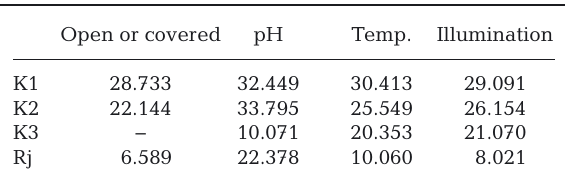
3. Analysis of the half-life data (d) of the L18 (2×3 3 ) ortho gonal experiment. K1, K2 and K3 are the averages of the different levels under the same conditions, Rj presents extreme differences in the data under the same treatment condition